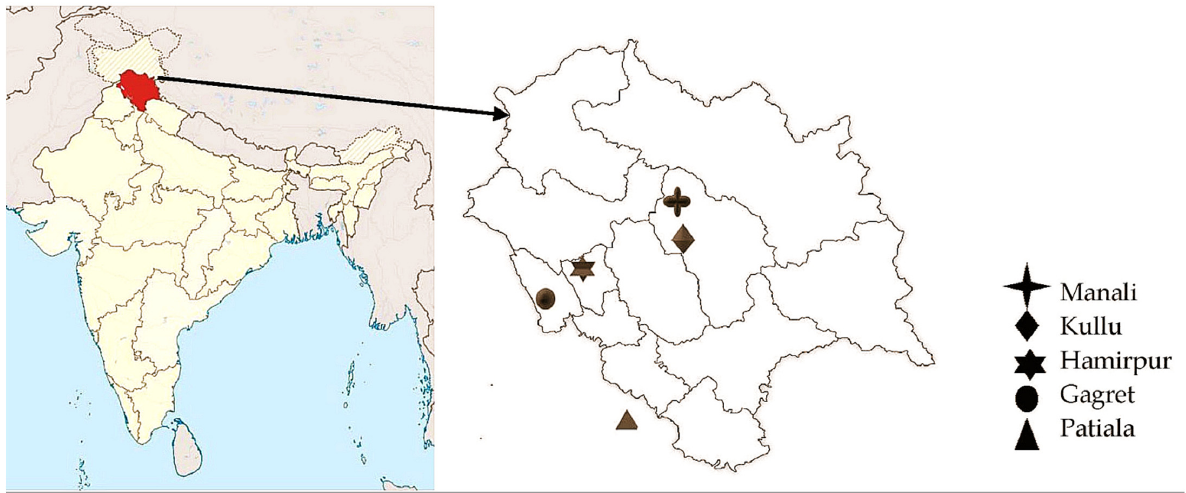
Figure 2. Map showing collection localities of beetle species.